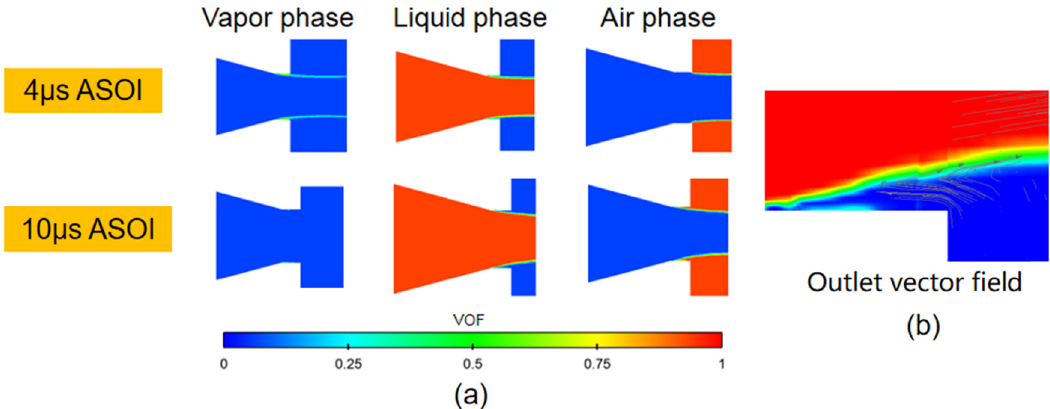
Figure 9: Development of the 30Y nozzle jet at the nozzle outlet.